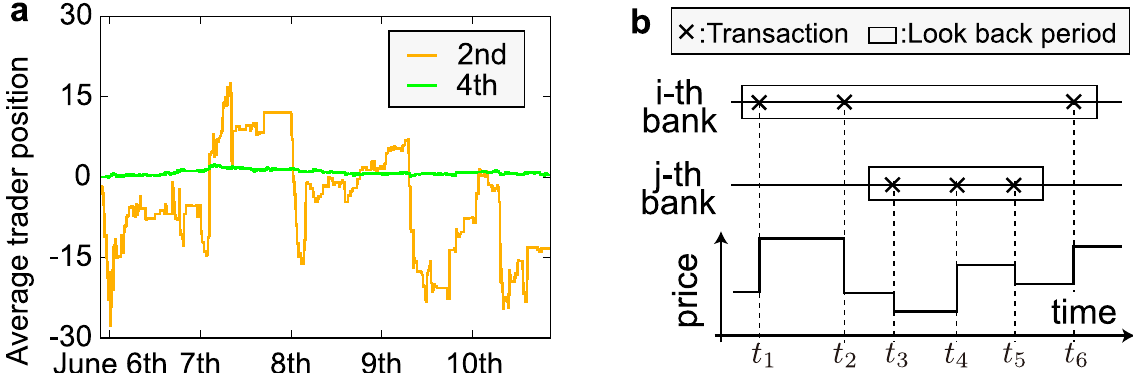
Fig 2. Classification of position management strategies. (a) Average trader positions for the second top (orange) and fourth top (green) banks plotted every 10 minutes. See Fig 1(b) for the definition of the rankings. A positive (negative) number represents a long (short) position in USD/JPY. (b) Schematic of the definition of the historical average position. The historical average position is calculated using the ensemble average of positions observed during past κ transactions undertaken by the considered bank ( κ = 3 in the example). Assume that the i -th bank transacted at times t 1 , t 2 , and t 6 , whereas the j -th bank transacted at times t 3 , t 4 , and t 5 . The historical average position of the i -th bank is the average of the positions at t 1 , t 2 , and t 6 , whereas that of the j -th bank is the average of the positions at t 3 , t 4 , and t 5